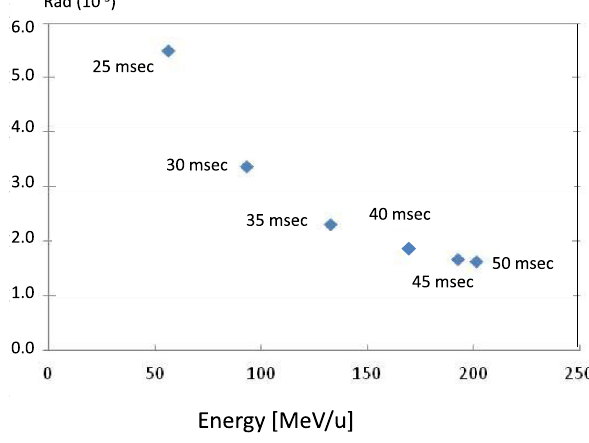
FIG. 24. RMS values for small scattering angle per wire.